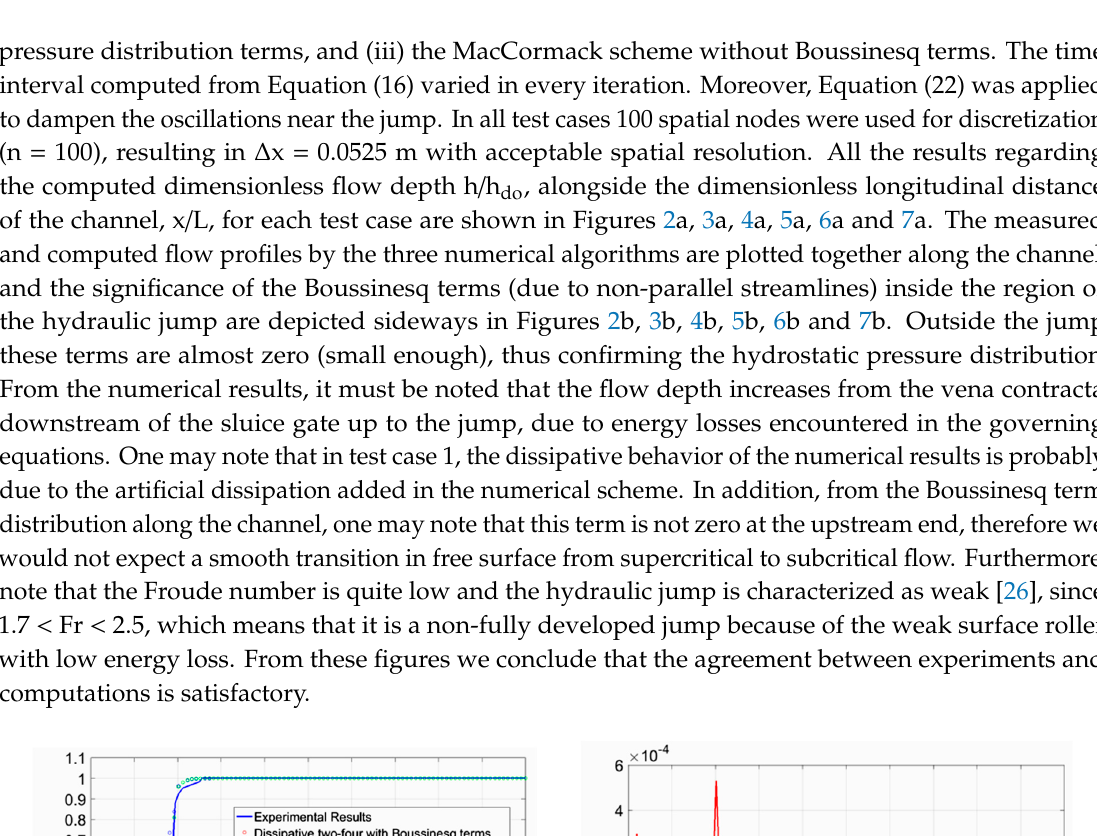
Figure 4. Experimental and Numerical Results for test case 3: ( a ) Free surface profile; ( b ) Boussinesq term versus distance.